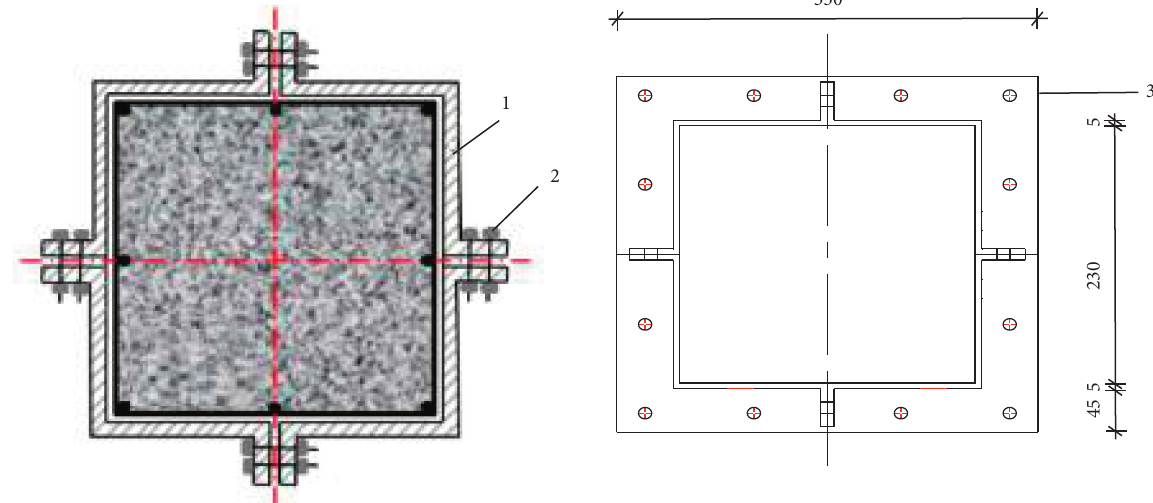
Figure 1: Schematic diagram of reinforcement method.